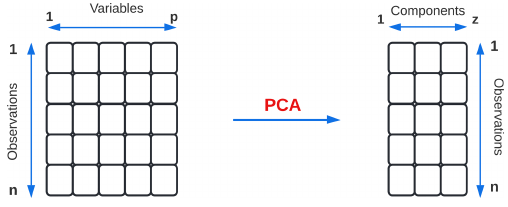
Figure 6. Dimensionality reduction by applying